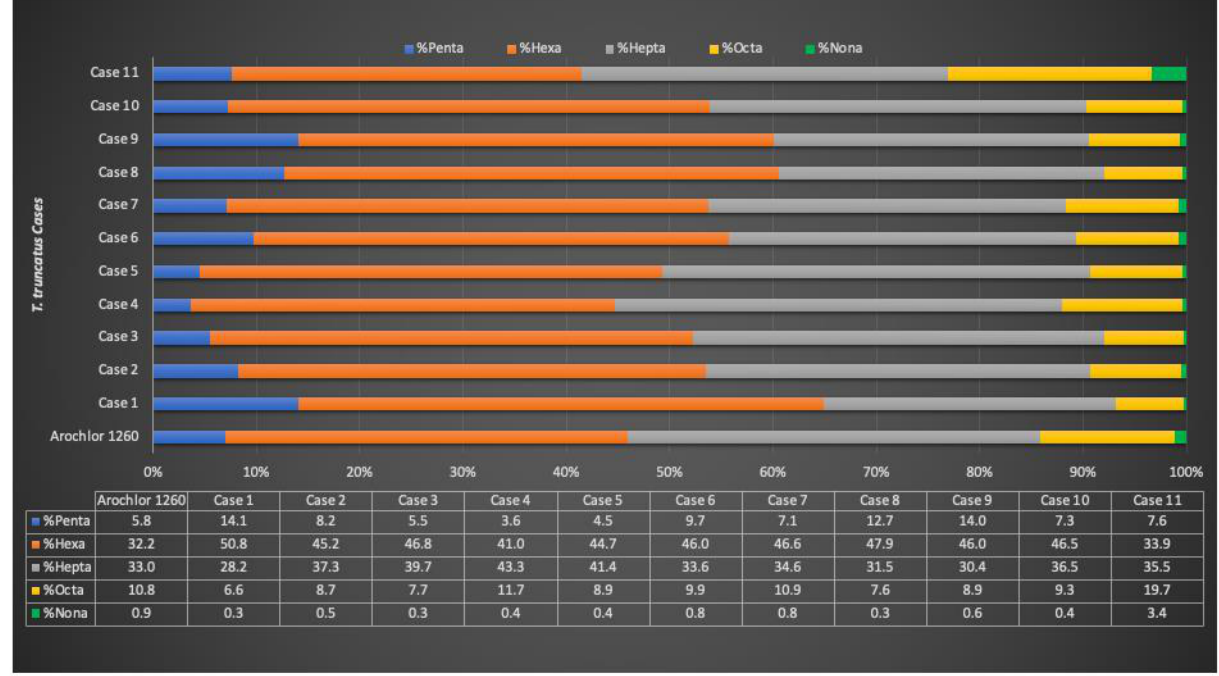
Figure 4. Percentage composition of the polychlorinated biphenyls (PCBs) divided by chlorine content (Penta-CBs, Hexa-CBs, Hepta-CBs, Octa-CBs, Nona-CBs) on Total PCBs found in blubber of the different specimens of T. truncatus and present in Arochlor 1260.